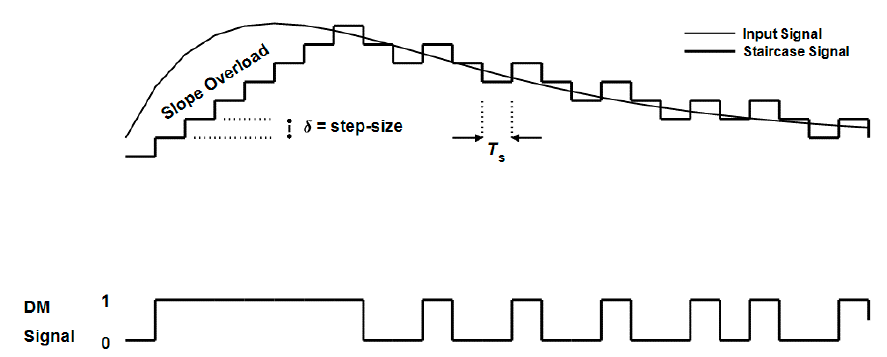
Figure 3. Example of delta modulation